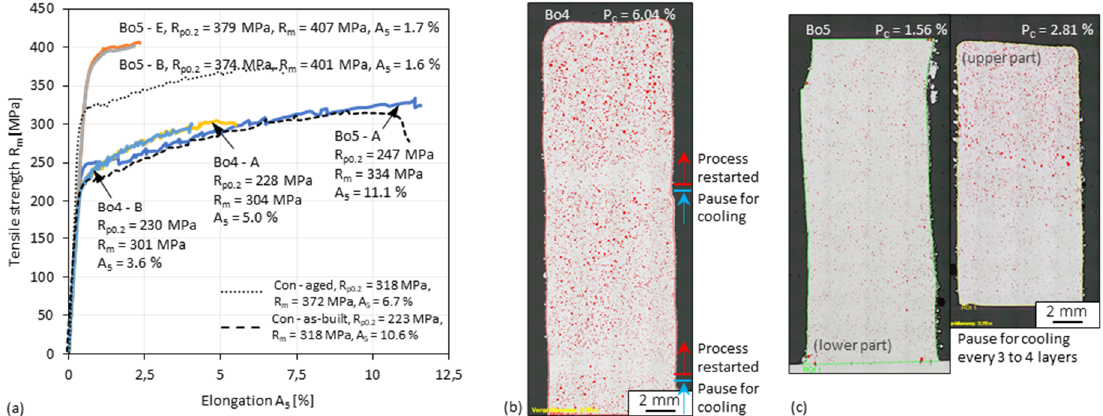
Figure 18. ( a ) Tensile performance of Bo4 and Bo5 in the as-built and aged state. Microscopic images of the cross-section of ( b ) Bo4 and ( c ) Bo5. The specimen “Con-aged (5 h at 300 °C, air cooled)” and “Con-as-built” are reference specimens fabricated by conventional DED using the laser power of 620 W, travel speed of 550 mm/min, powder feed rate of 0.18 g/min, and other settings according to [41] (more details is shown in Figure A2 in Appendix B).